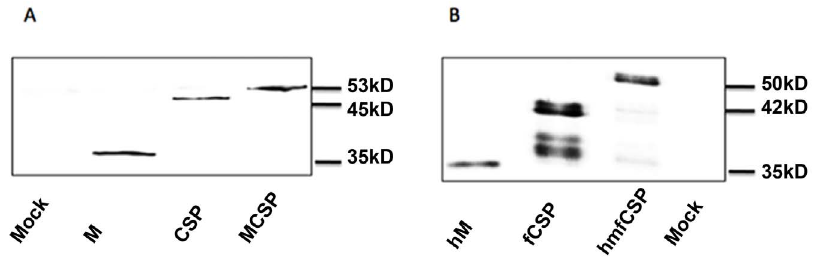
Figure 2. Western blot analysis of expression of constructs of malaria DNA vaccines and controls. P. yoelii (A) and P. falciparum (B) DNA vaccine candidates and control constructs were transfected into and expressed from 293T cells. Protein expression into culture supernatant was detected with anti-myc antibody 48 hours after transfection. In each lane the vaccine constructs are the uppermost bands with lower bands of fCSP representing proteolytic fragments of the expressed proteins. CSP=a fragment of the P. yoelii circumsporozoite protein, fCSP=a fragment of the P.